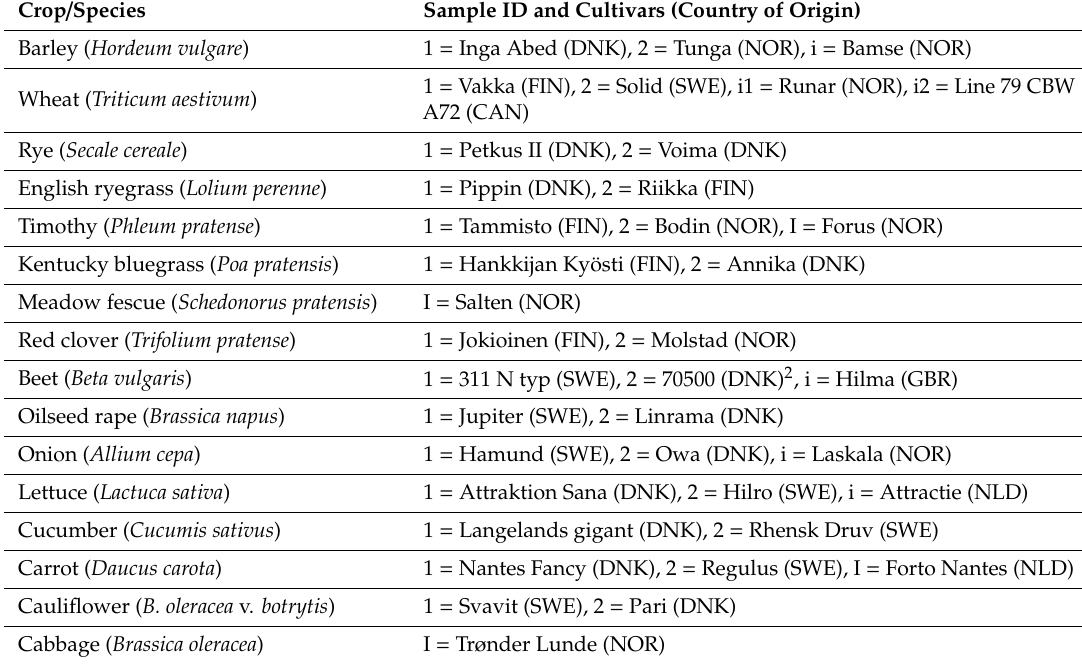
Table 3. Overview of the examined crops and sample information. A prefix number refers to the samples with no information on seed-borne diseases, while a prefix i-letter refers to the samples where we detected seed-borne diseases to be present at the start of the experiment. Crop / Species Sample ID and Cultivars (Country of